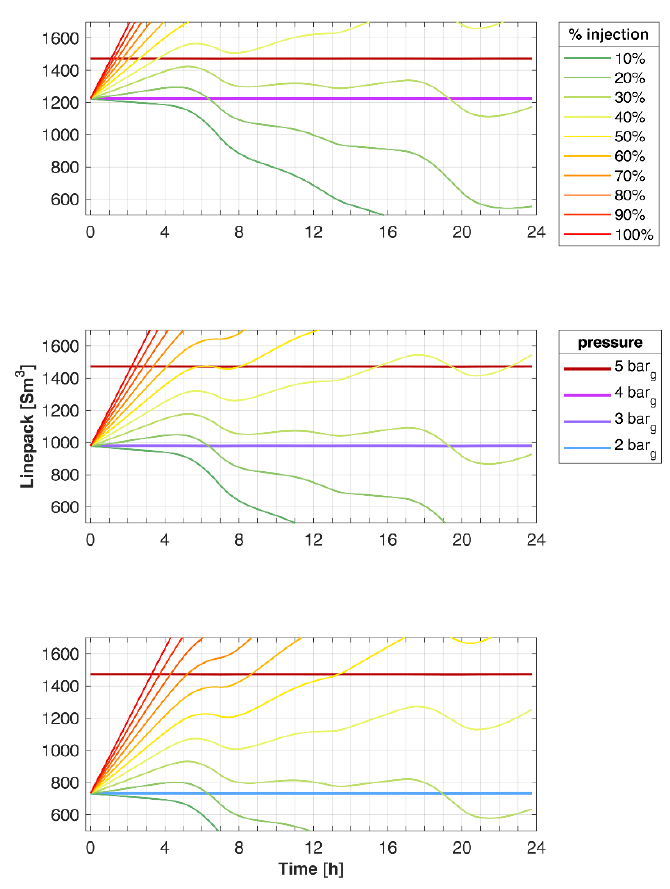
Figure 7. Variation of the gas accumulation within the network (i.e., linepack evolution) in function of the % reduction of the biomethane injection rate. The multicolor solid lines represent the different injection cases by steps of 10% reduction. Each graph refers to a different lowered pressure set point: from the top to the bottom: 4 bar g , 3 bar g , 2 bar g . The maximum acceptable linepack (corresponding to 5 bar g ) is indicated on every graph as the maximum limit (dark red